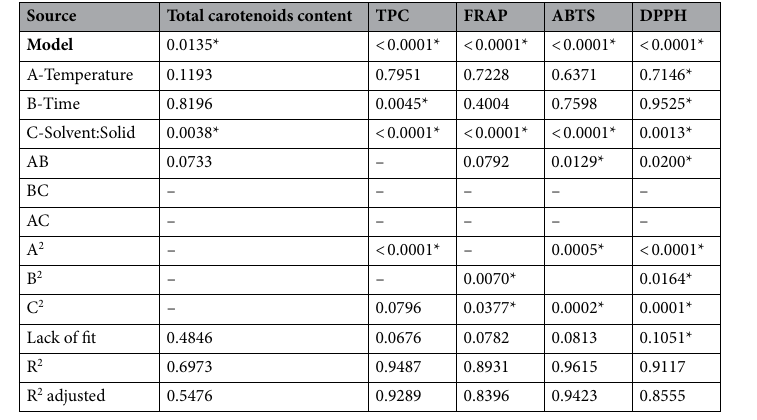
Table 5. ANOVA and regression analysis of CCD responses of Study